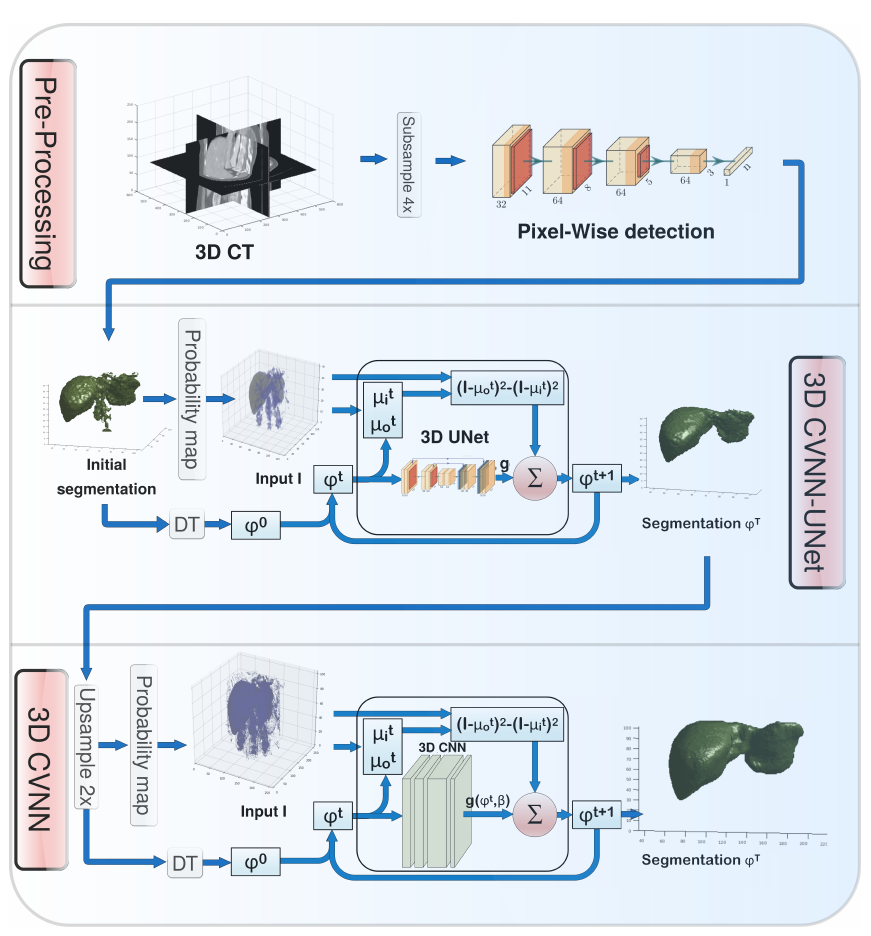
Figure 2. Diagram of the entire Deep Chan-Vese 3D organ segmentation